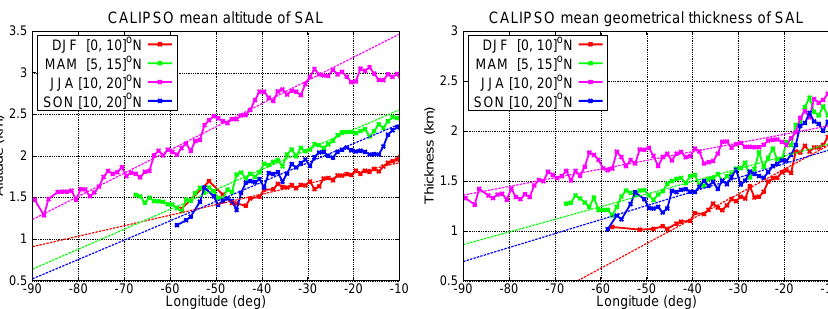
Fig. 7. Mean zonal evolution of SAL altitude (left) and geometrical thickness (right) based on CALIPSO data from Africa ( − 10 ◦ E) to the Americas ( − 90 ◦ E). Each point is an average over 10 ◦ in latitude (indicated in the legend) depicting the mainly position of SAL in every season. The dotted lines are the linear fits for every season (see text for details).